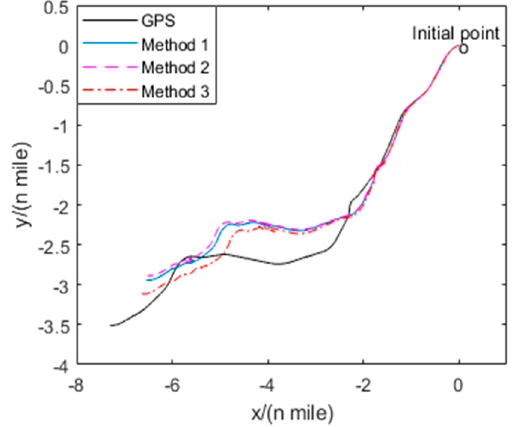
Figure 13. Trajectories of the navigation results.